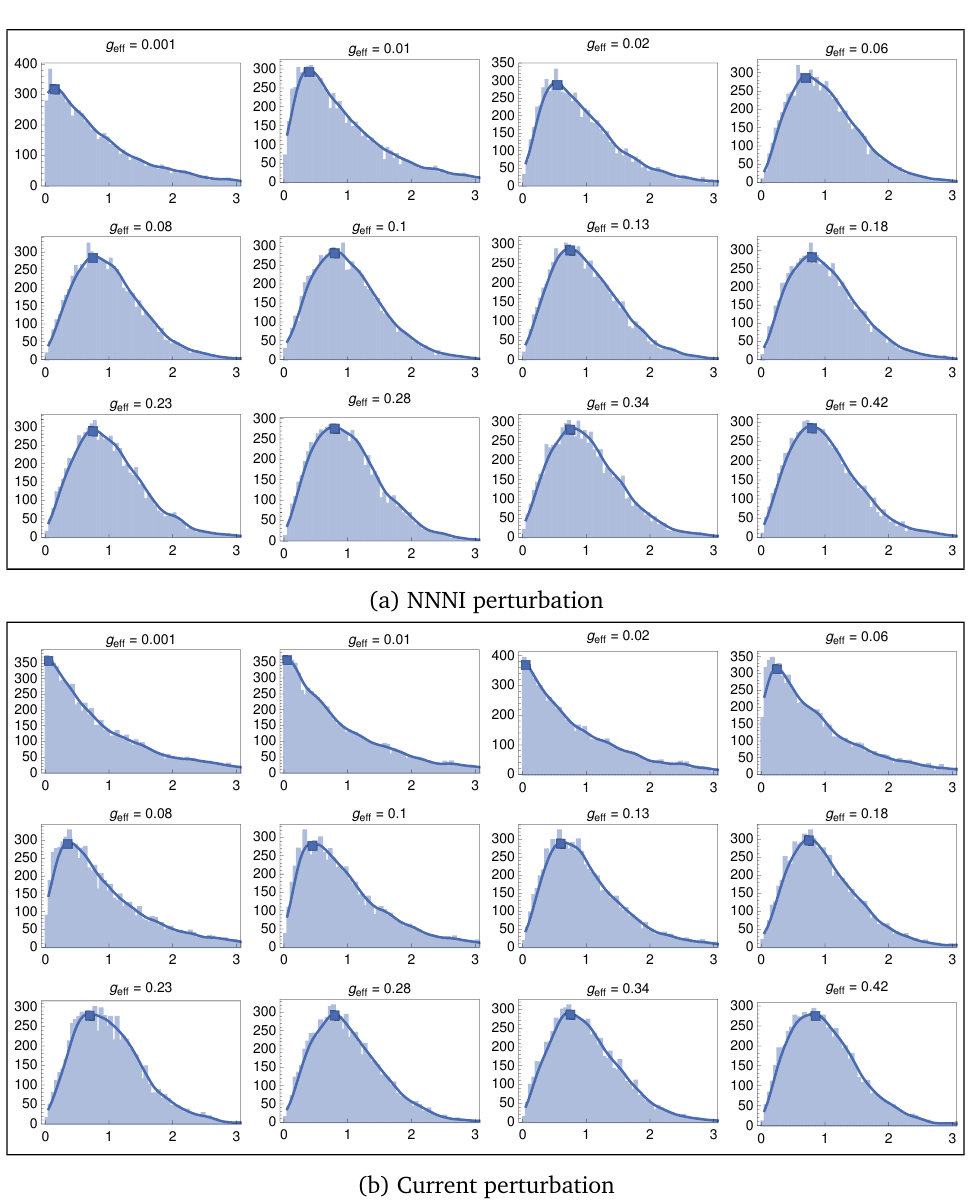
Figure 4: Determining the dependence of the peak position on g (a) and current (b) perturbations for L = 22, ∆ = 0.2. The blue solid lines mark the result of the Gaussian filtering and the blue markers denote the extracted peak